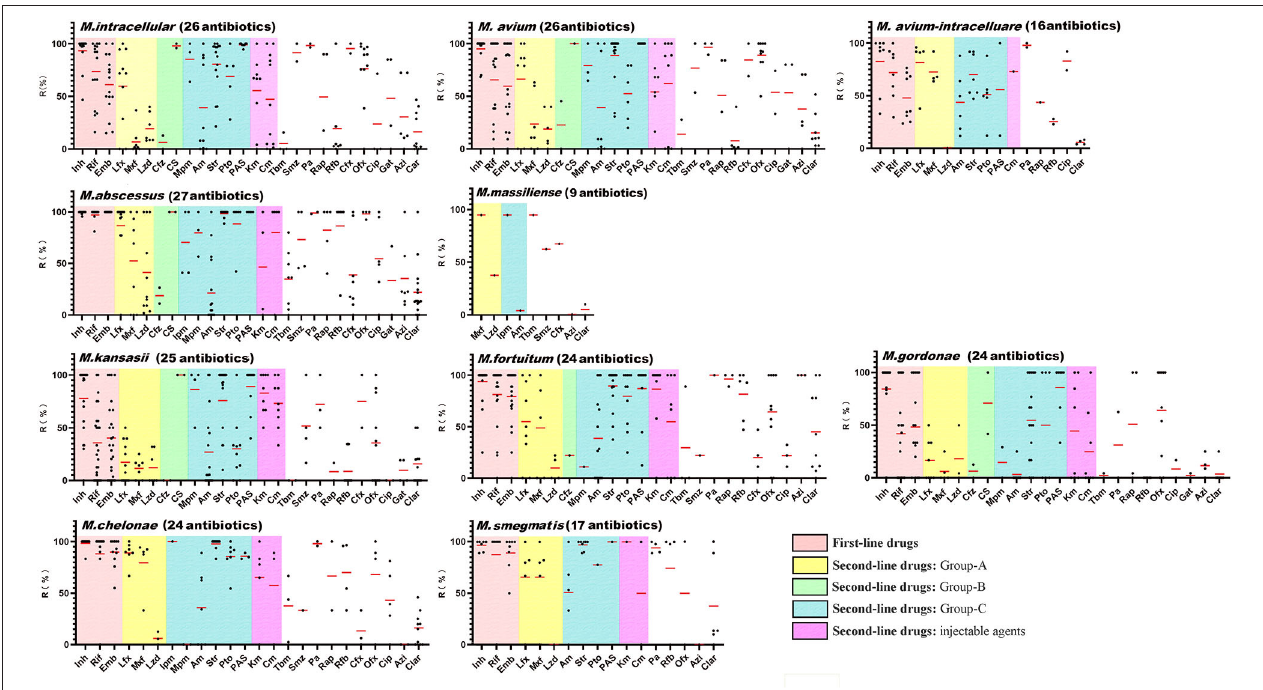
FIGURE 5 | Non-tuberculous mycobacteria isolation rates in mainland